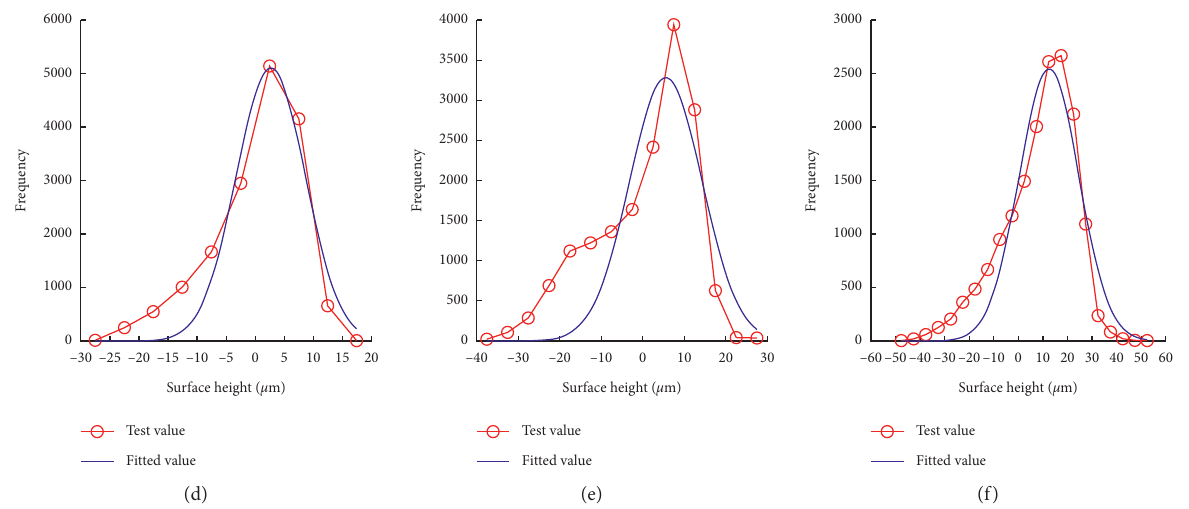
Figure 11: The normality test of surface height distribution during fatigue. (a) 0 cycle. (b) 2000 cycles. (c) 4000 cycles. (d) 6000 cycles. (e) 8000 cycles. (f) Fracture.